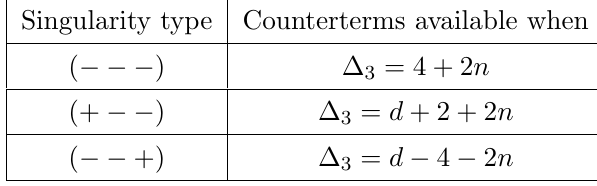
Table 8 . Availability of counterterms for h T (cid:22)